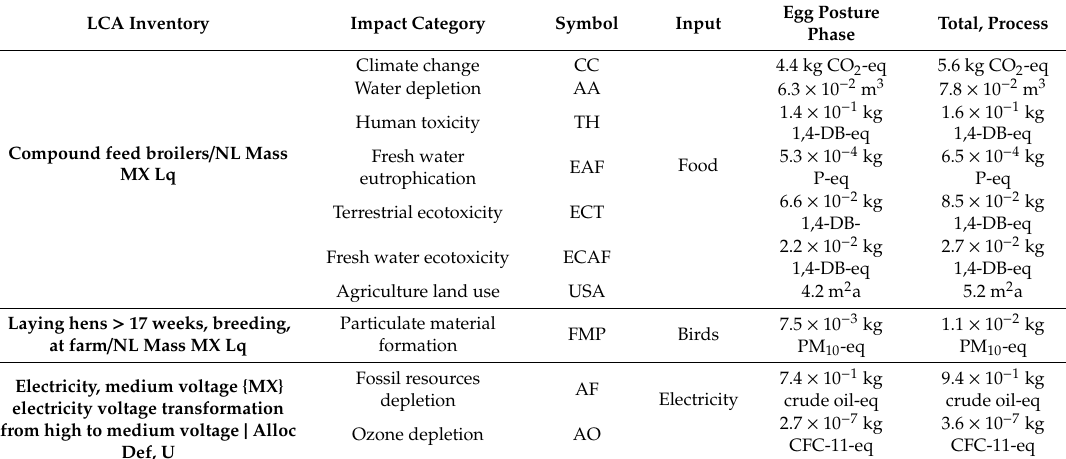
Table 5. Significant impact categories for egg posture phase and total shelf egg production process (per